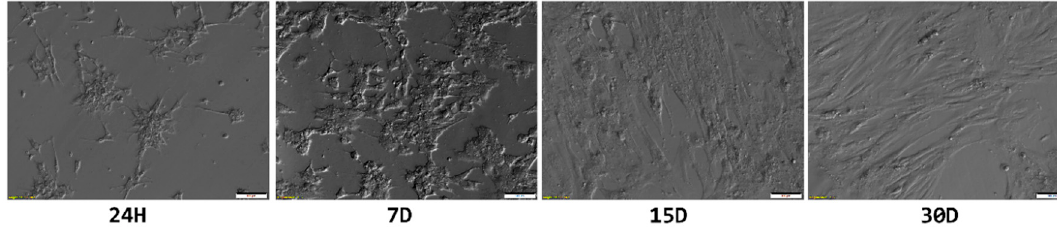
Figure 6. Light microscope observations of changes in granulosa cell morphology during long-term in vitro culture. H—hour; D—day.